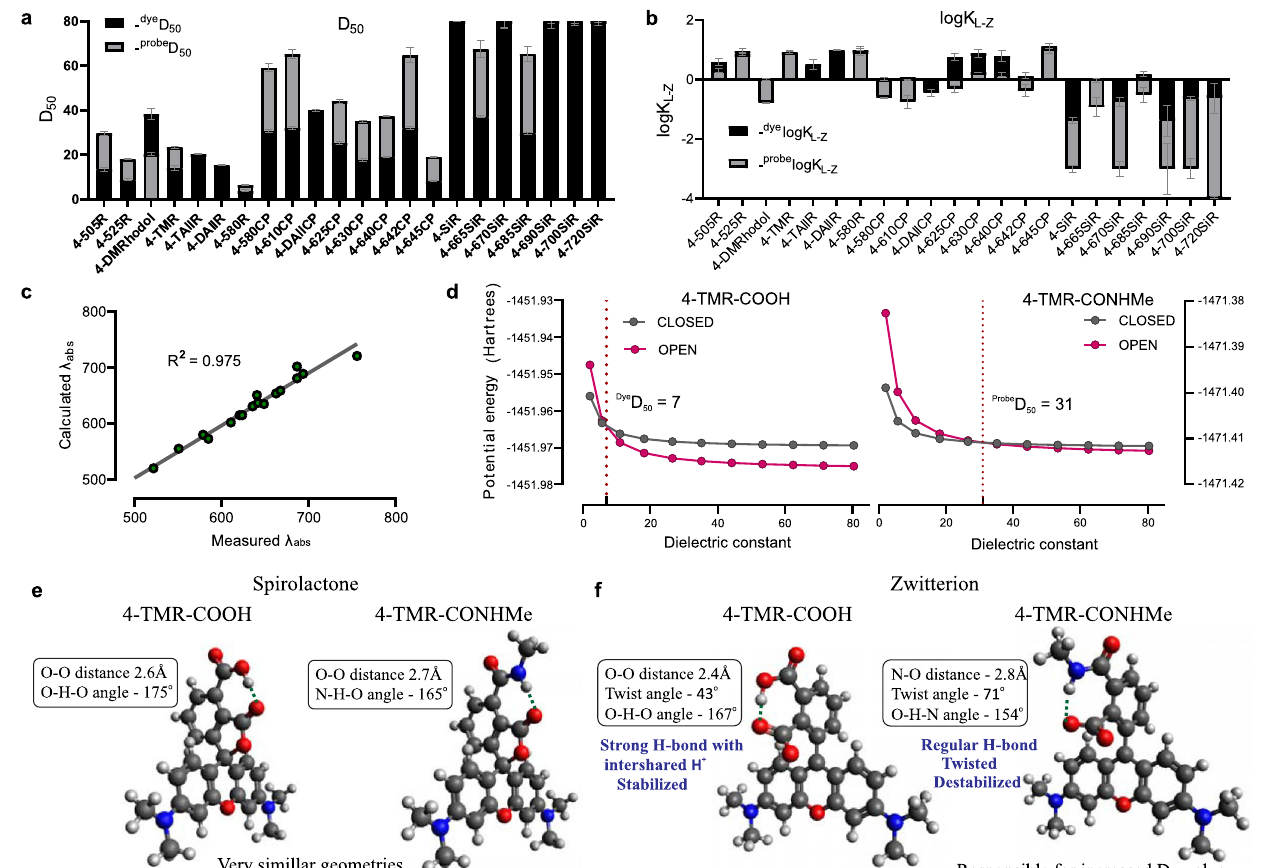
Fig.4|Invitroandinsilicocharacterizationofthedyes.a dye D 50 and probe D 50 and b dye log K L – Z and probe log K L – Z values represented in a stacked bar chart. Data are presented as mean values±SD, n =3 independent experiments. c Correlation between TDDFT calculated and experimentally measured absorption maxima of the dyes in water. d Plots of DFT calculated potential energies of zwitterion and